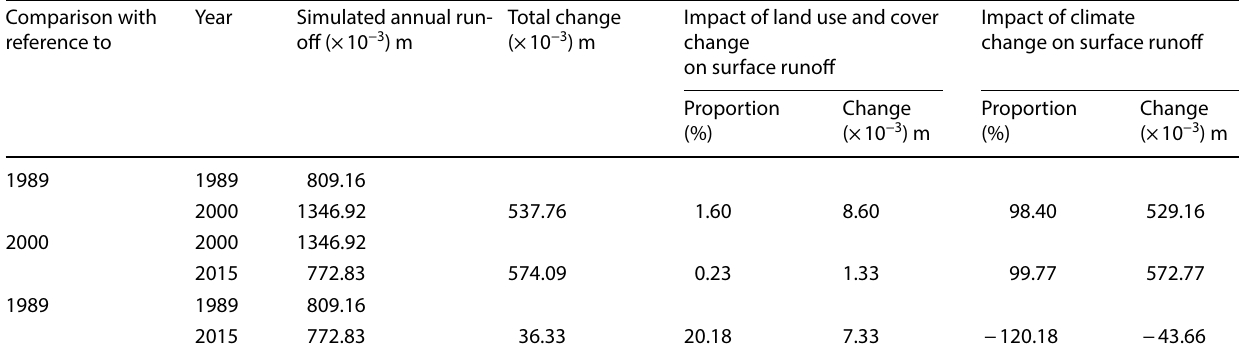
Table 13 Impact proportions on surface runoff (1989–2015) Comparison with reference